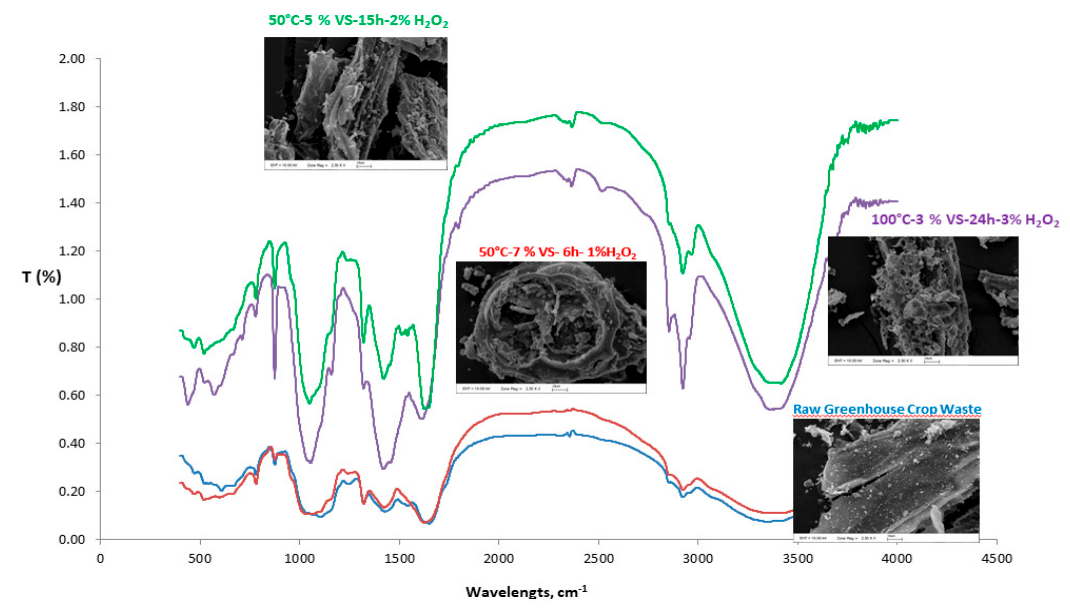
Figure 6. Fourier-transform infrared (FTIR) spectra and SEM images of raw and pretreated greenhouse crop waste. Table 3. Comparison of Fourier-transform infrared (FTIR) spectra of waste pretreated with alkaline H 2 O 2 under different conditions with with that of raw greenhouse crop waste.